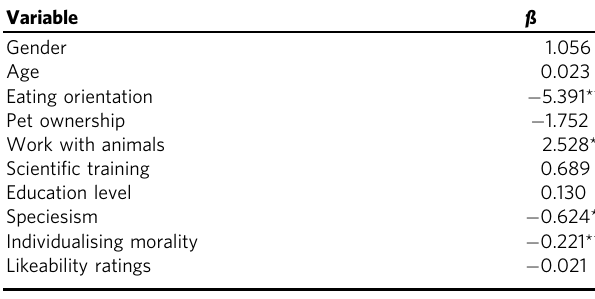
Table 3 Unstandardised beta coef fi cients for single step linear regression of demographic variables, likeability ratings, speciesism and individualising morality scores on APQ-total score.